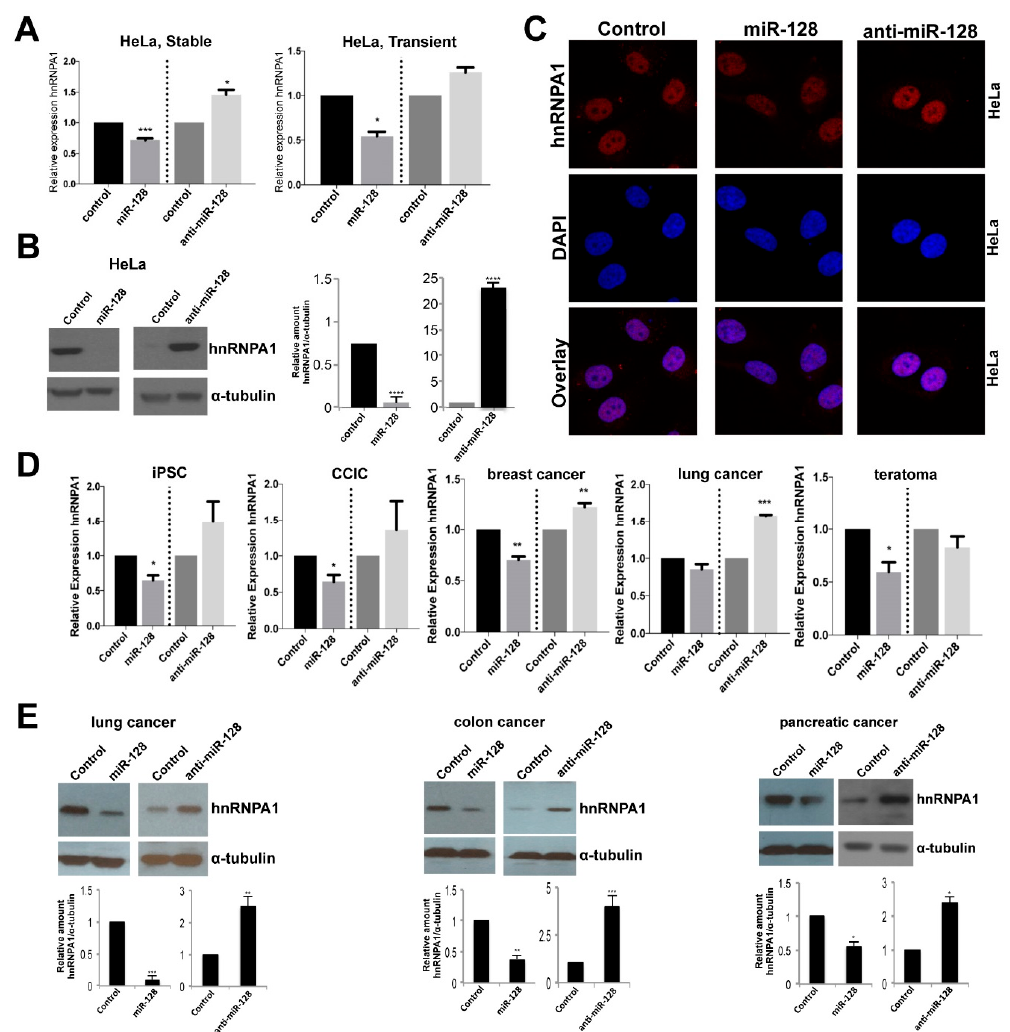
western blot result. Di ff erent exposures of independent biological replicates are shown for miR-128 versus anti-miR-128 experiments. Together, these results demonstrate that miR-128 regulates hnRNPA1 mRNA and protein levels in multiple cell types.